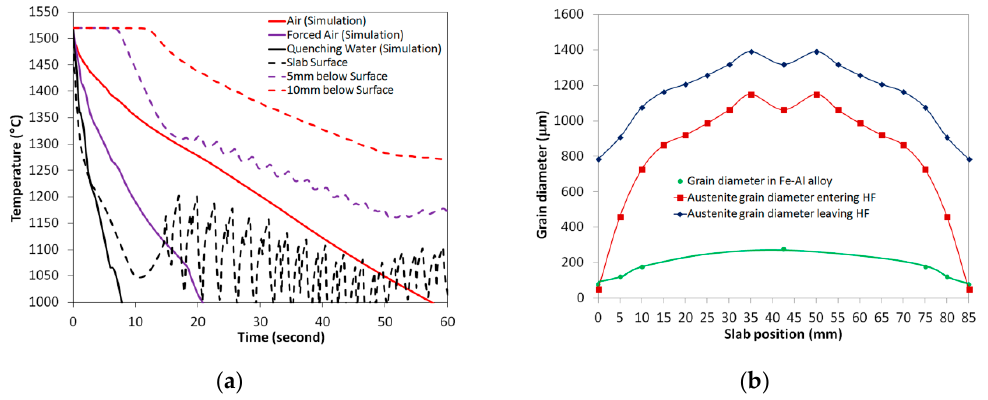
Figure 14. ( a ) Comparison of CON1D predicted temperature profiles on the surface and 5 and 10 mm below the API X70 85 mm slab, and the recorded thermal profile during simulation process [37]; ( b ) comparison of grain size evolution with slab distance using the TSCDR process to produce API X70 and Fe-Al new alloy.